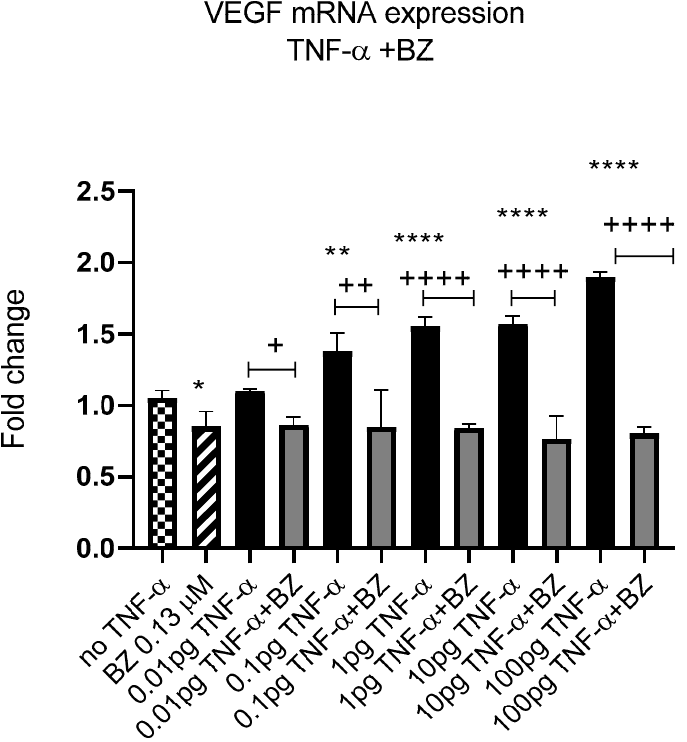
Figure 12. NF-kB involvement in TNF- α -induced VEGF in SW480. Cells were treated with 0.13 µ M of Bortezomib (BZ) with TNF- α dose range of (0.01–100 pg/mL) for 24 h. Significant differences are shown for comparisons between inhibitor treated cells vs. untreated cells (+ p < 0.05, ++ p < 0.01, ++++ p < 0.0001) and compared with vehicle control (no TNF- α ) (* p < 0.05, ** p < 0.01, **** p < 0.0001). Significance was assessed using one-way ANOVA (GraphPad Prism 8). Data are presented as a mean and error bars represent the SEM for six replicates and two independent cultures.